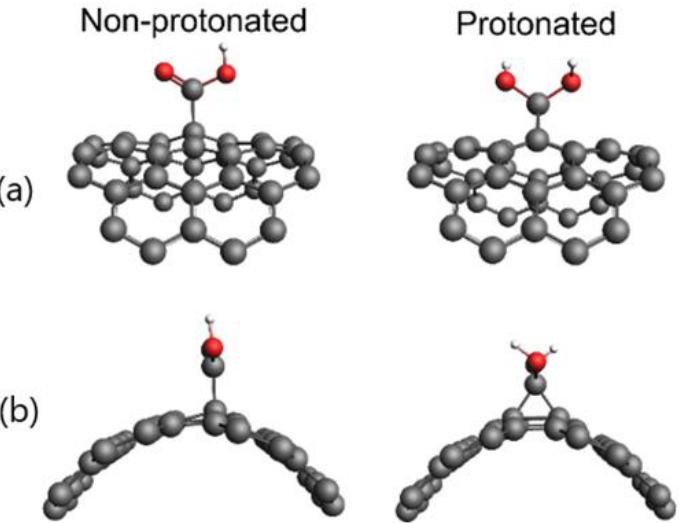
Figure 3. Close proximity of carboxyl groups in the SWCNT-COOH and pSWCNT-COOH ( a ) top views and ( b ) side views, as obtained by DFT/GFN-xTB optimization.